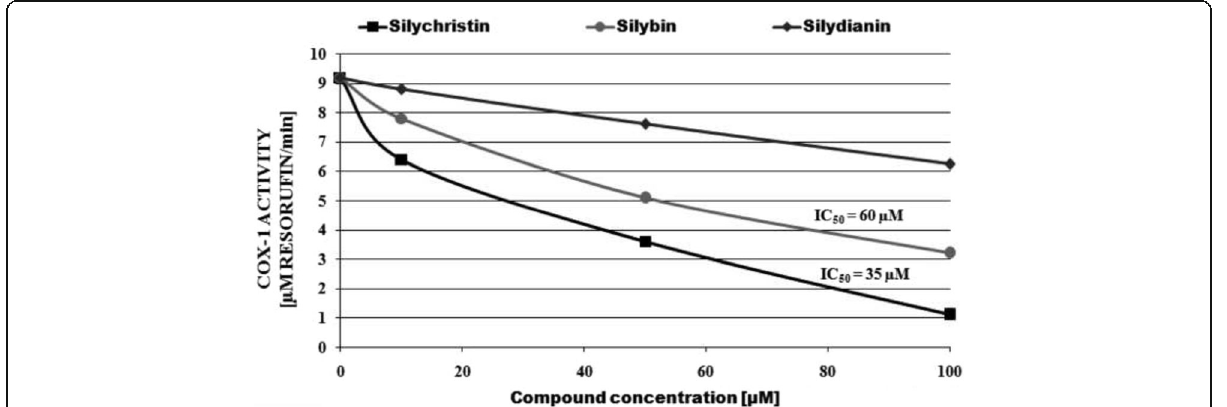
Fig. 4 The effect of flavonolignans (silychristin, silybin and silydianin at concentrations 10; 50 and 100 μ M) on the level of oxygenase activity of COX-1 in platelets. The Figure shows the average rate of change of Resorufin formation. The data represents the means of 12